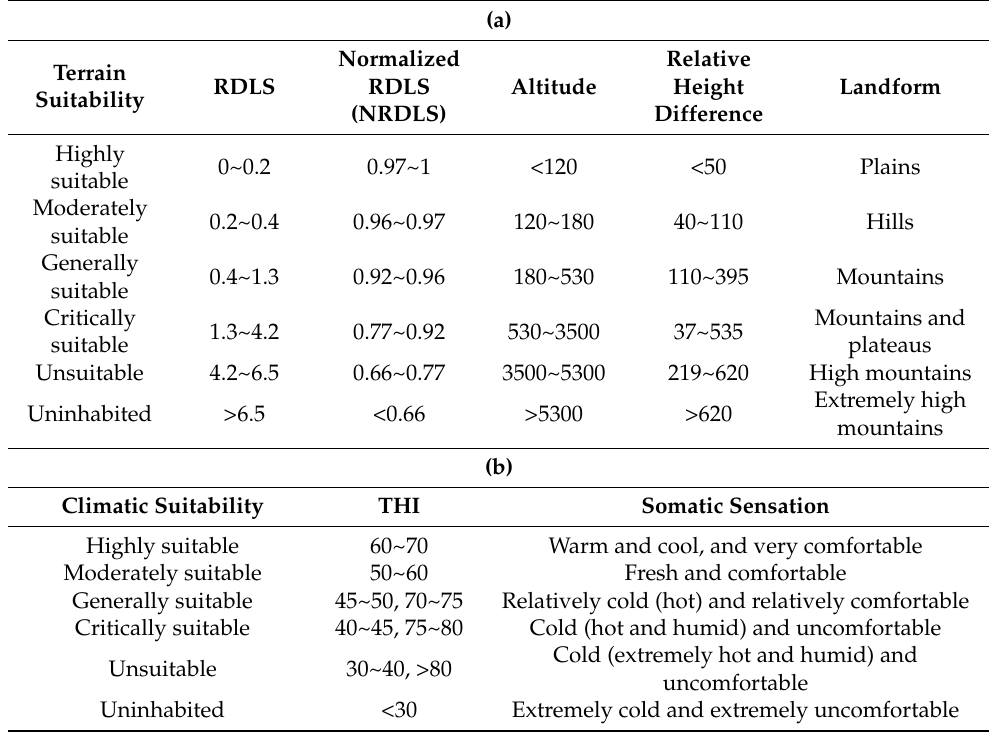
Table 1. ( a ) Classification of the single-factor suitability indices—terrain suitability. ( b ) Classification of the single-factor suitability indices—climatic